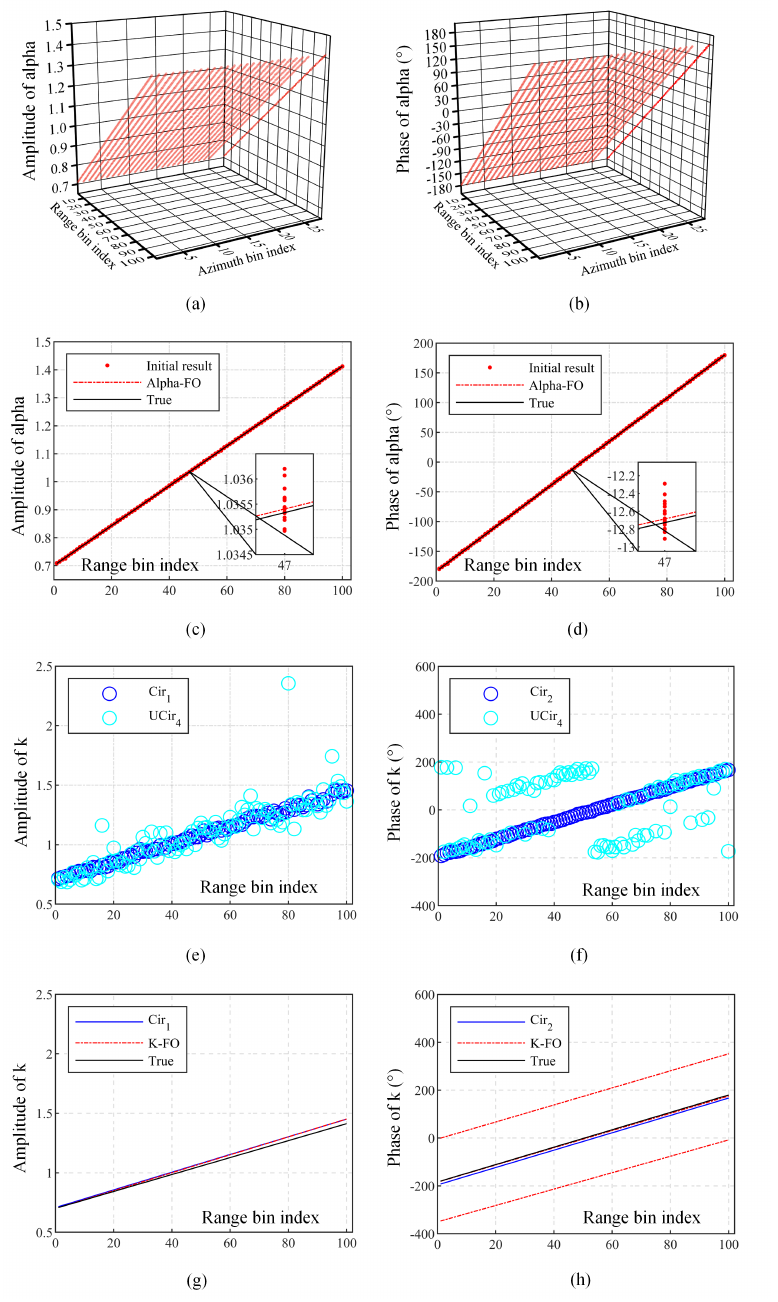
Figure 7. Estimated PolCAL parameters of the simulated CQP SAR images: ( a , b ) initial amplitude and phase results of α ; ( c , d ) alpha filter amplitude and phase; alpha-FO indicates the α filtering results; ( e , f ) initial amplitude and phase results of k ; ( g , h ) K filter amplitude and phase; K-FO denotes the k filtering results after using Cir 1 &UCir 4 /UCir 4 to estimate the initial amplitude/phase of k . Compared to the added values (‘True’ in Figure 7c,d) of α , the amplitude and phase errors of α with the proposed scheme are 2.4516 × 10 − 4 dB/0.4865 ◦ , respectively, according to (31); according to (32), error α is 0.0085. According to (31), comparing the estimated k of the control group (‘Cir 1 ’ and ‘Cir 2 ’ in Figure 7g,h) with the added values (‘True’ in Figure 7g,h), the amplitude and phase errors of k are 0.1783 dB and 12.5263 ◦ ,